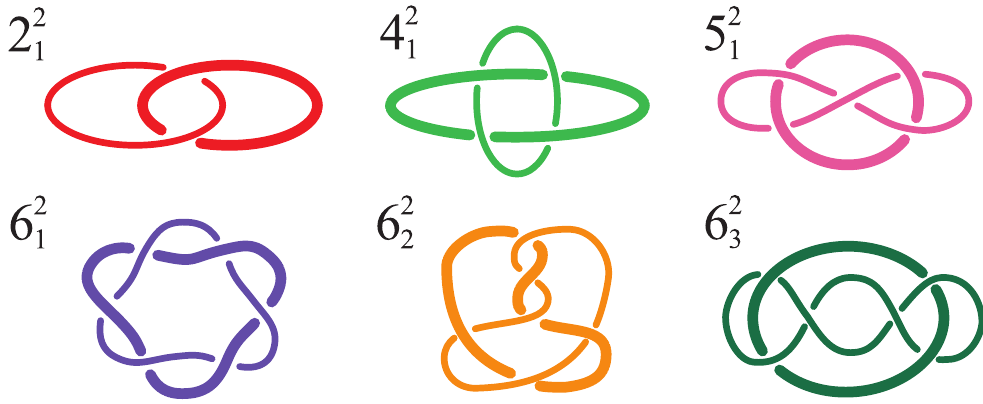
Figure 2. Sketches of two-component links considered in this study. For visual clarity, the components are drawn with different thickness. The links are listed by increasing complexity according to Rolfsen’s nomenclature [4]. The considered repertoire consists of: the simplest (Hopf) link type, 2 2 link, 4 2 , the Whitehead link, 5 2 , and the first three six-crossings links in the Rolfsen’s table, 6 2 1 1